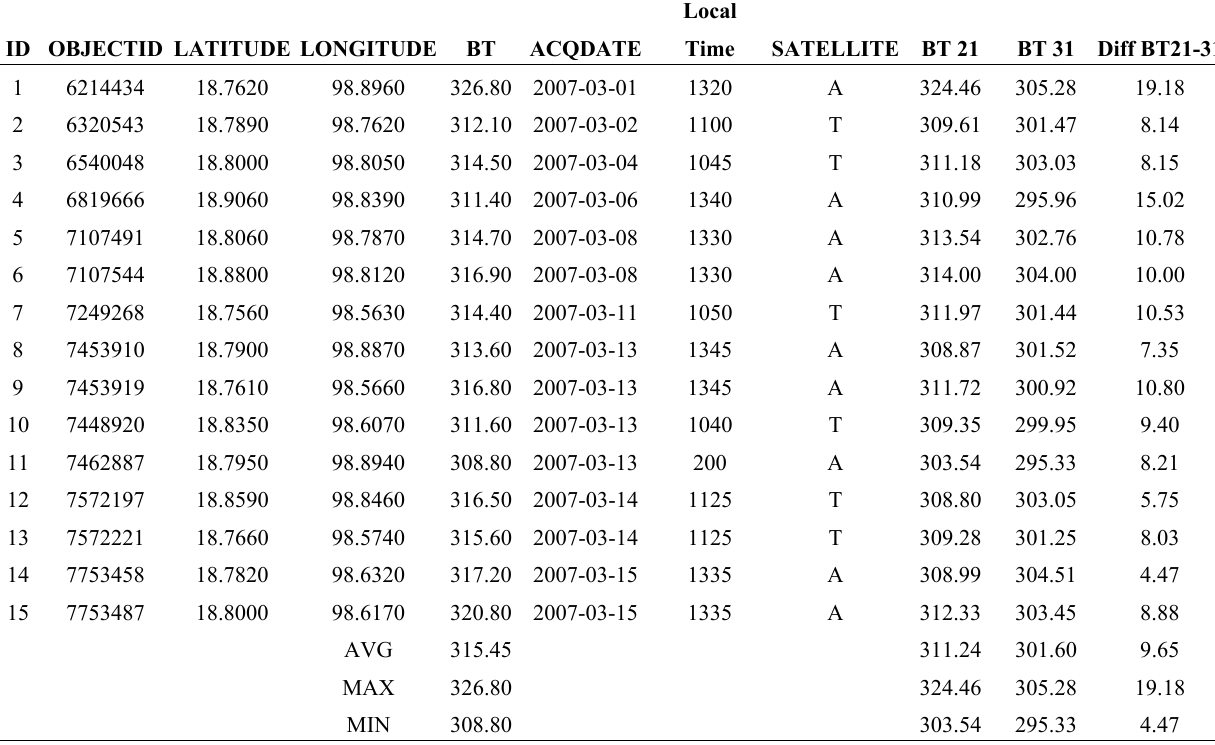
Table 4. Examples of hotspots brightness temperatures in the North.